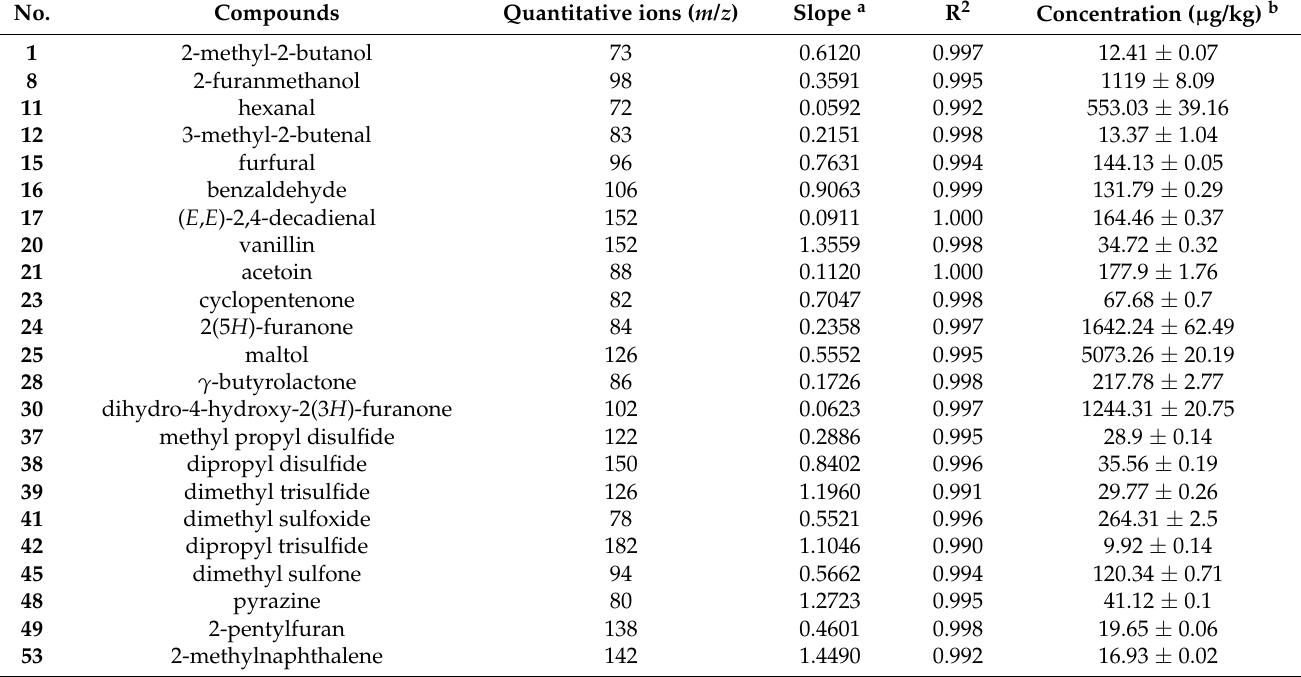
Table 2. Concentrations of 23 aroma-active compounds in SP.